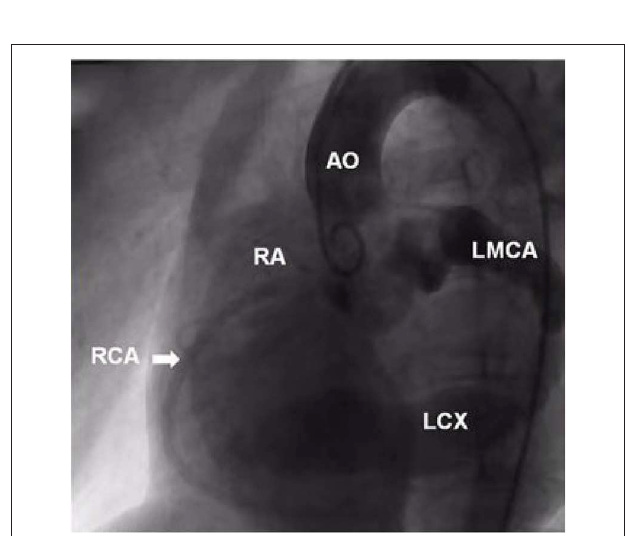
FIGURE 4 | Ascending aorta and coronary angiography view showed the dilated left main and circumflex coronary arteries. The distal LCX showed a stage of aneurysmal dilatation. AO, aorta; RA, right atrium; RCA, right coronary artery; LMCA, left main coronary artery; LCX, left circumflex